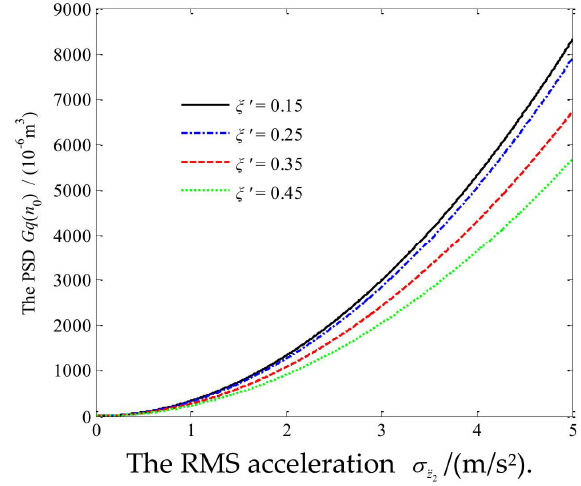
 . Figure 3. The curve of the PSD G q ( n 0 ) versus the RMS acceleration σ .. z  2 2 z